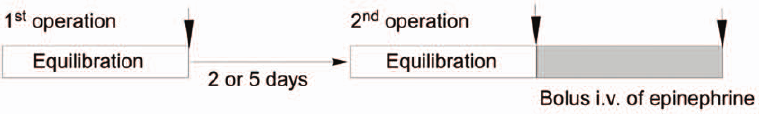
Figure 7. Study protocol 2 of experiments. Monophasic action potentials were recorded after the equilibration at both the peri-infarct zone and the unaffected zone of the epicardium during each open chest operation and at the time point of peak adrenergic excitation. MAP duration data were expressed as MAPD90/60/30 pre-op, post-op, epi i.v. , which stood for MAPD90/60/30 recorded at first operation, at second operation, and after the bolus intravenous injection of epinephrine,